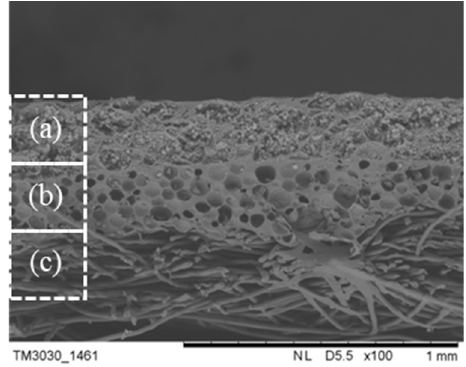
Figure 8. SEM image of the MPF: ( a ) the SiO 2 aerogel thermal insulation layer; ( b ) the microPCM function layer; ( c ) PP + the far-infrared fabric layer.